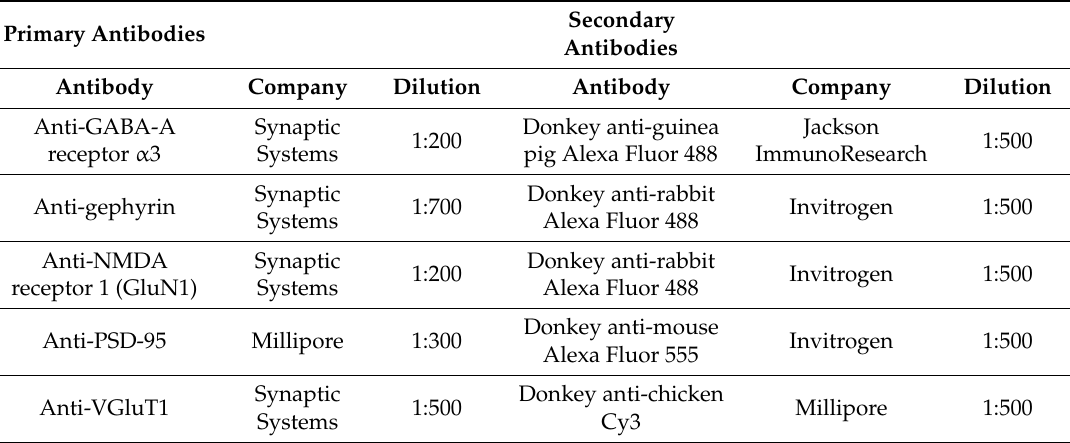
Table 1. Primary and corresponding secondary antibodies used for